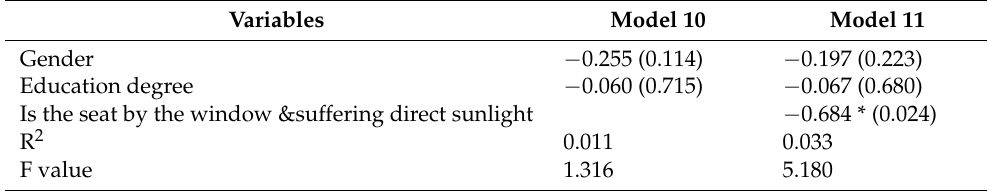
Table 4. Post hoc analysis on unit1 with “Learning experience” as the dependent variable (N = 280).